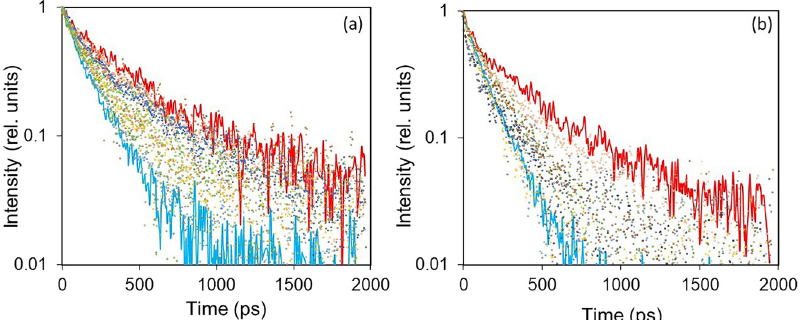
Figure 5: Spread of emission kinetics in HITC:PMMA films deposited on top of arrays of Ag nanowires in alumina membranes at dye concentrations n = 9.5 g/l (a) and n = 24.6 g/l (b). Red and blue solid lines indicate the upper and the lower boundaries of the emission kinetics spreads,